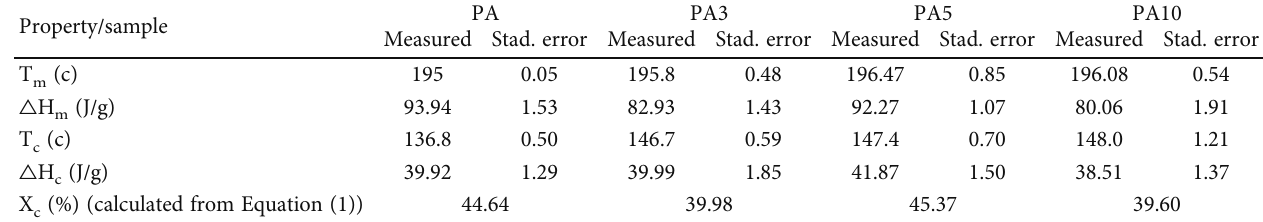
Table 1: Thermal properties of PA and its composites (PA3, PA5, and PA10). Property/sample